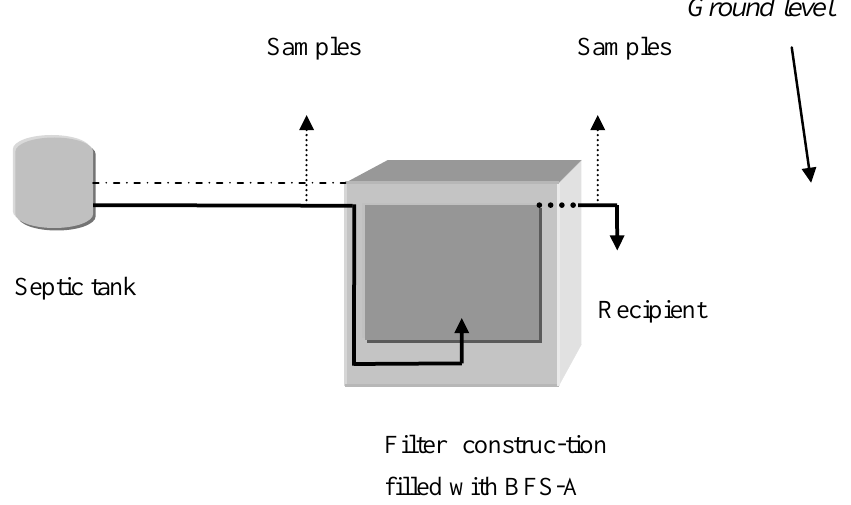
Figure 1. Experimental set-up of filter box system for P-removal